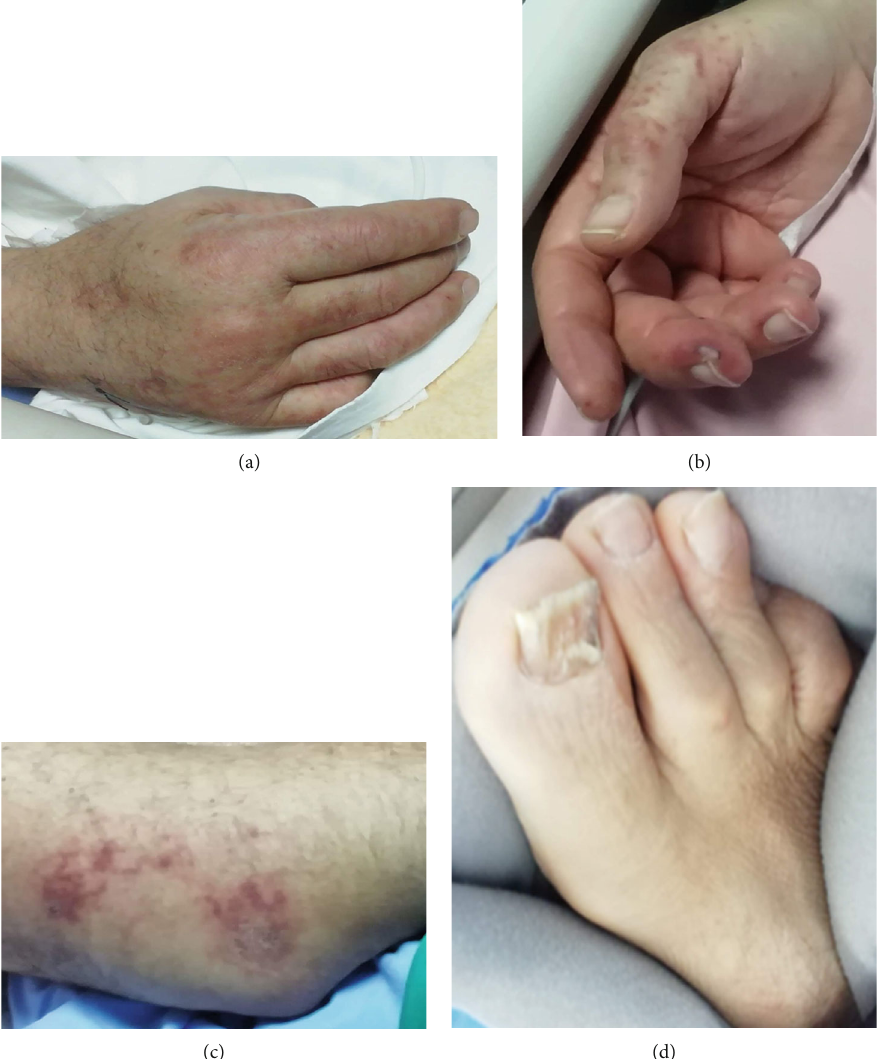
Figure 4: Improvement of lesions on dorsal (a) and palmar (b) area of hands, elbows (c), and lower limbs (d) seven days after initial